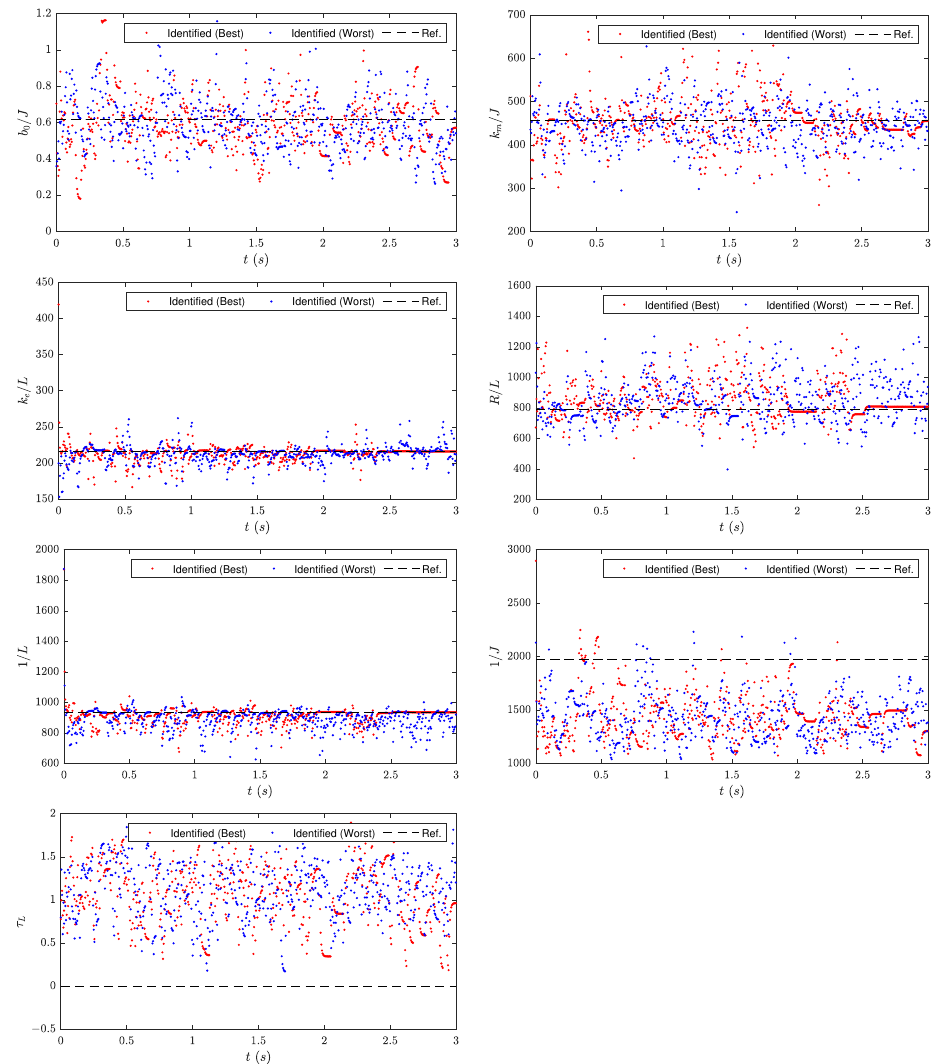
Figure 12. Identified motor parameters for the best and worst runs of CATSCG considering NOC. An additional point to consider is the execution time of each optimization